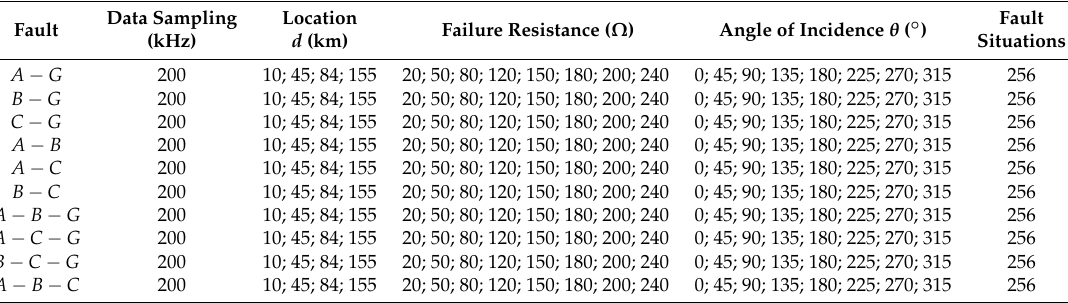
Table 2. Situations of simulated